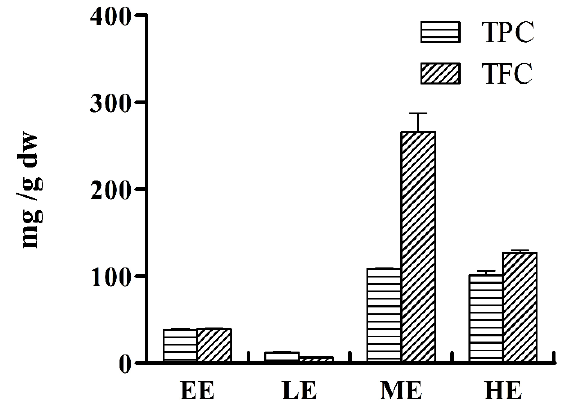
Figure 2. The total phenolic content (TPC) and total flavonoid content (TFC) in different extracts and their fractions of AMF.